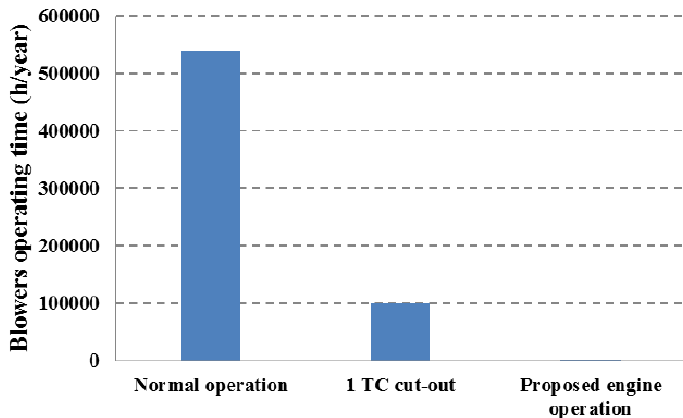
Figure 11. Annual blowers operating time (per operating unit); Normal operation: three blowers operate; Operation with 1 TC cut-out: two blowers operate; Proposed engine operation: one blower